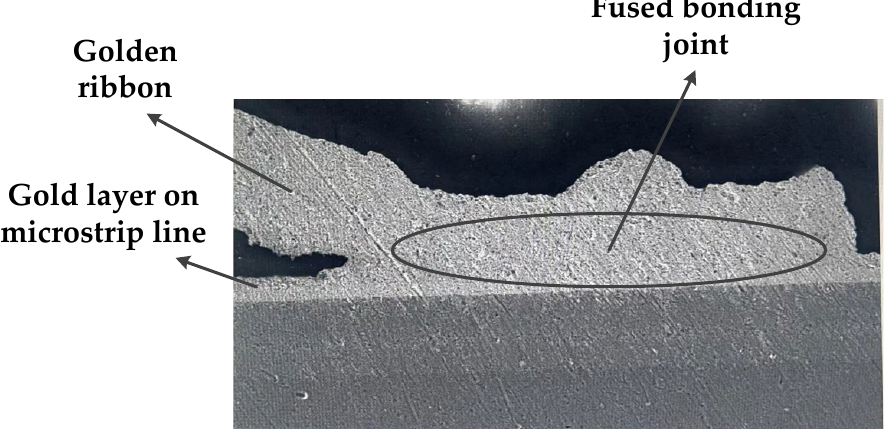
Figure 25. The metallographic analysis of the bonding joints in the Ka band receiving SIP.